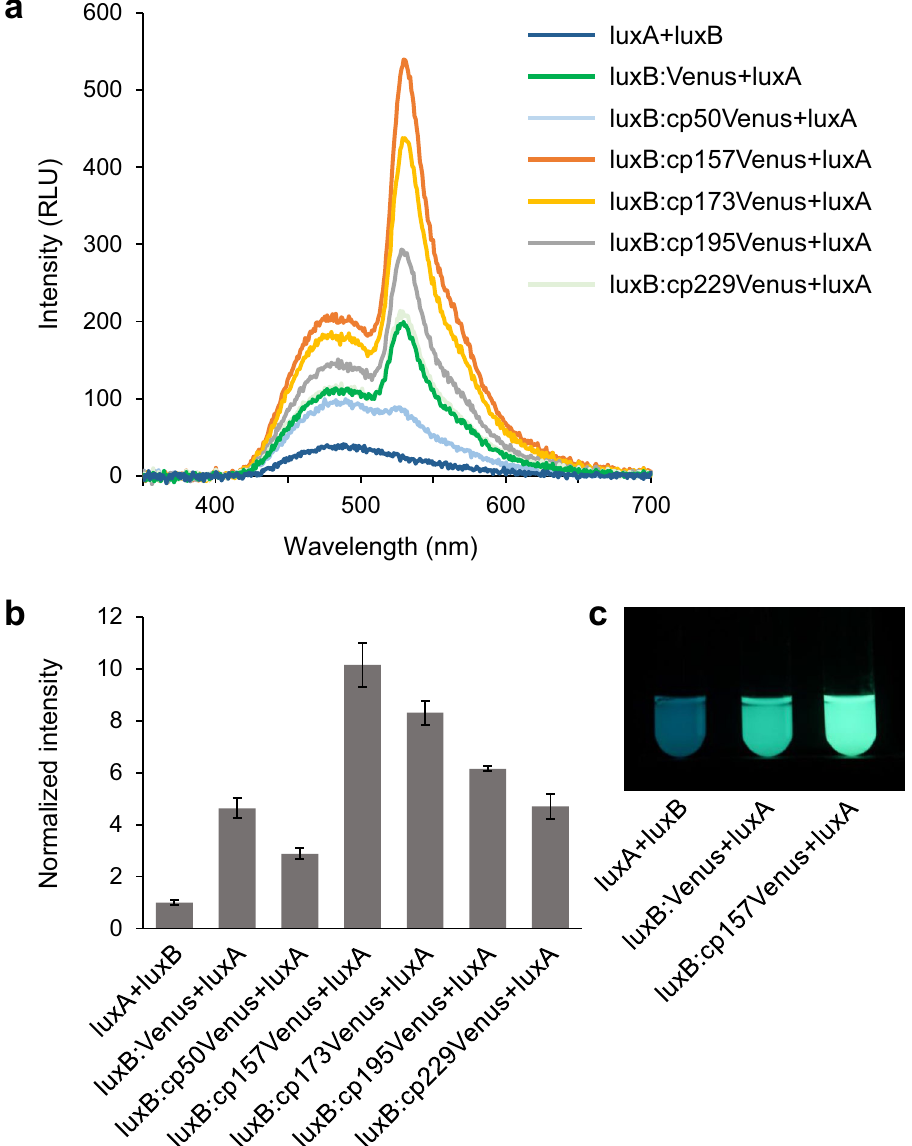
Figure 3. Brightness of luciferase variants fused to circularly permuted Venus. ( a ) Luminescence spectra measured in the whole cell suspensions of JM109(DE3) expressing the recombinant proteins from each construct. The luminescence reaction was initiated by the addition of 1% decanal. ( b ) Luminescence intensities of the whole cell suspensions expressing the recombinant proteins. Data are means ± SD of three different clones. ( c ) The 2 ml cultures of JM109(DE3) expressing luxA + luxB, luxB:Venus + luxA and luxB:cp157Venus + luxA after the addition of decanal. The photograph was taken by SONY α7s, ISO 5000, exposure time 2